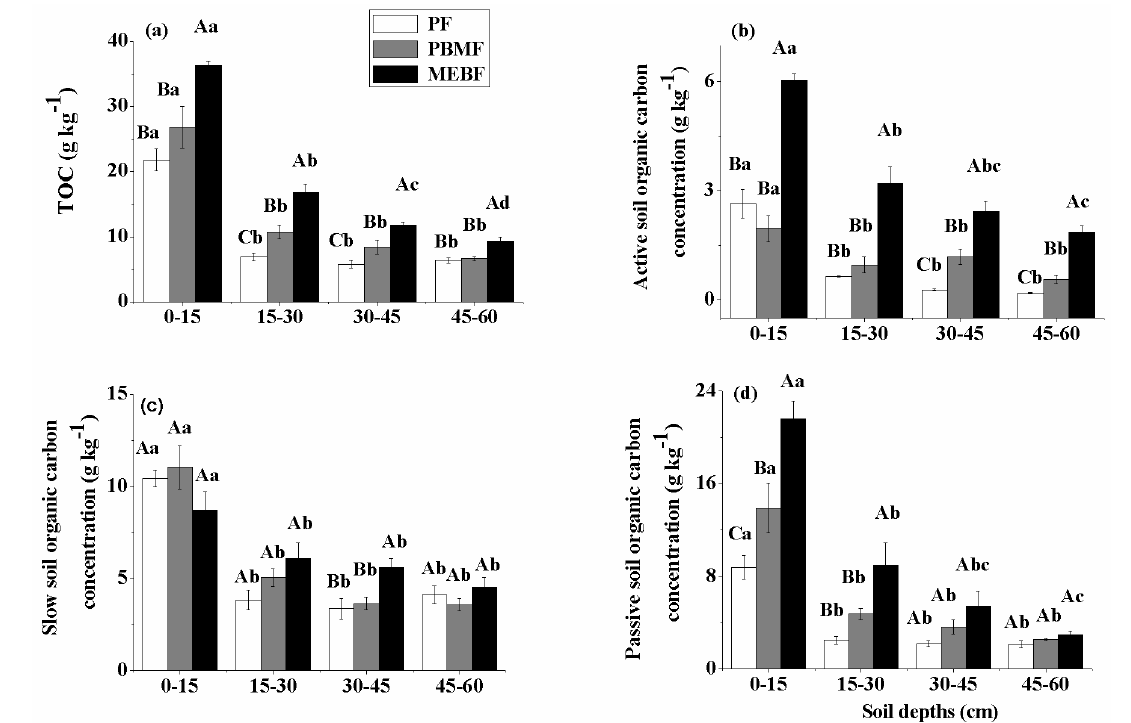
Figure 1. Total soil organic carbon (TOC) ( a ); active soil organic carbon (SOC) ( b ); slow SOC ( c ); and passive SOC ( d ) concentrations in the three forests. Different uppercase letters indicate a significant difference between different stages of forest succession at p < 0.05. For the same forest and SOC fraction, different lowercase letters indicate significant differences between depths at p < 0.05. PF: pine forest; PBMF: pine and broadleaved mixed forest; MEBF: monsoon evergreen broadleaf